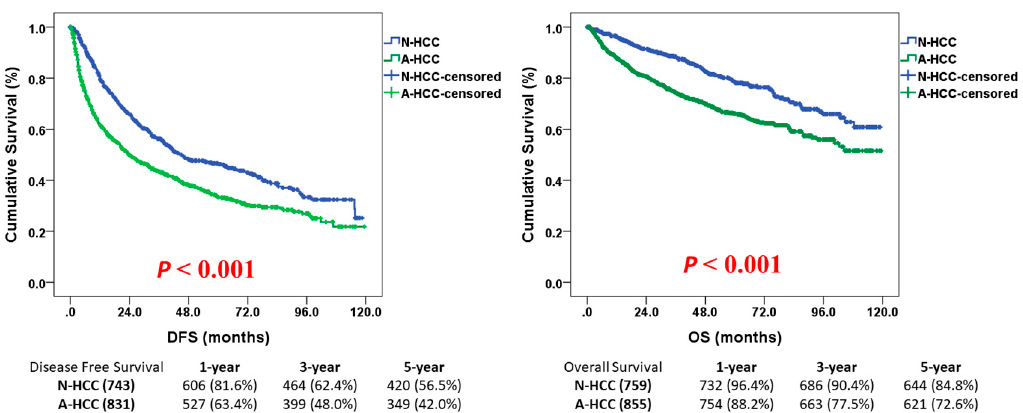
Figure 1. Kaplan–Meier disease-free survival (DFS) and overall survival (OS) curves for hepatocellular carcinoma with normal (N-HCC) or abnormal (A-HCC) AFP. A, Disease-free survival curves. The median DFS was 44.6 months (95% CI 34.2–54.9) for N-HCC and 23.6 months (95% CI 18.7–28.6) for A-HCC ( P < 0.001). The one-, three-, and five-year DFS rates were 81.6%, 62.4%, and 56.5%, respectively, for N-HCC and 63.4%, 48.0%, and 42.0%, respectively, for A-HCC. B. Overall survival curves. The mean OS was 94.5 months (95% CI 91.0–97.9) for N-HCC and 81.7 months (95% CI 78.0–85.3) for A-HCC ( P < 0.001). The one-, three-, and five-year OS rates were 96.4%, 90.4%, and 84.8%, respectively, for N-HCC and 88.2%, 77.5%, and 72.6%, respectively, for A-HCC. DFS, disease-free survival; OS, overall survival; N-HCC, normal α -fetoprotein HCC; A-HCC, abnormal α - fetoprotein HCC. Table 3. Univariate and cox regression multivariate analyses of factors associated with disease-free survival (DFS) a in N-HCC b after hepatectomy.